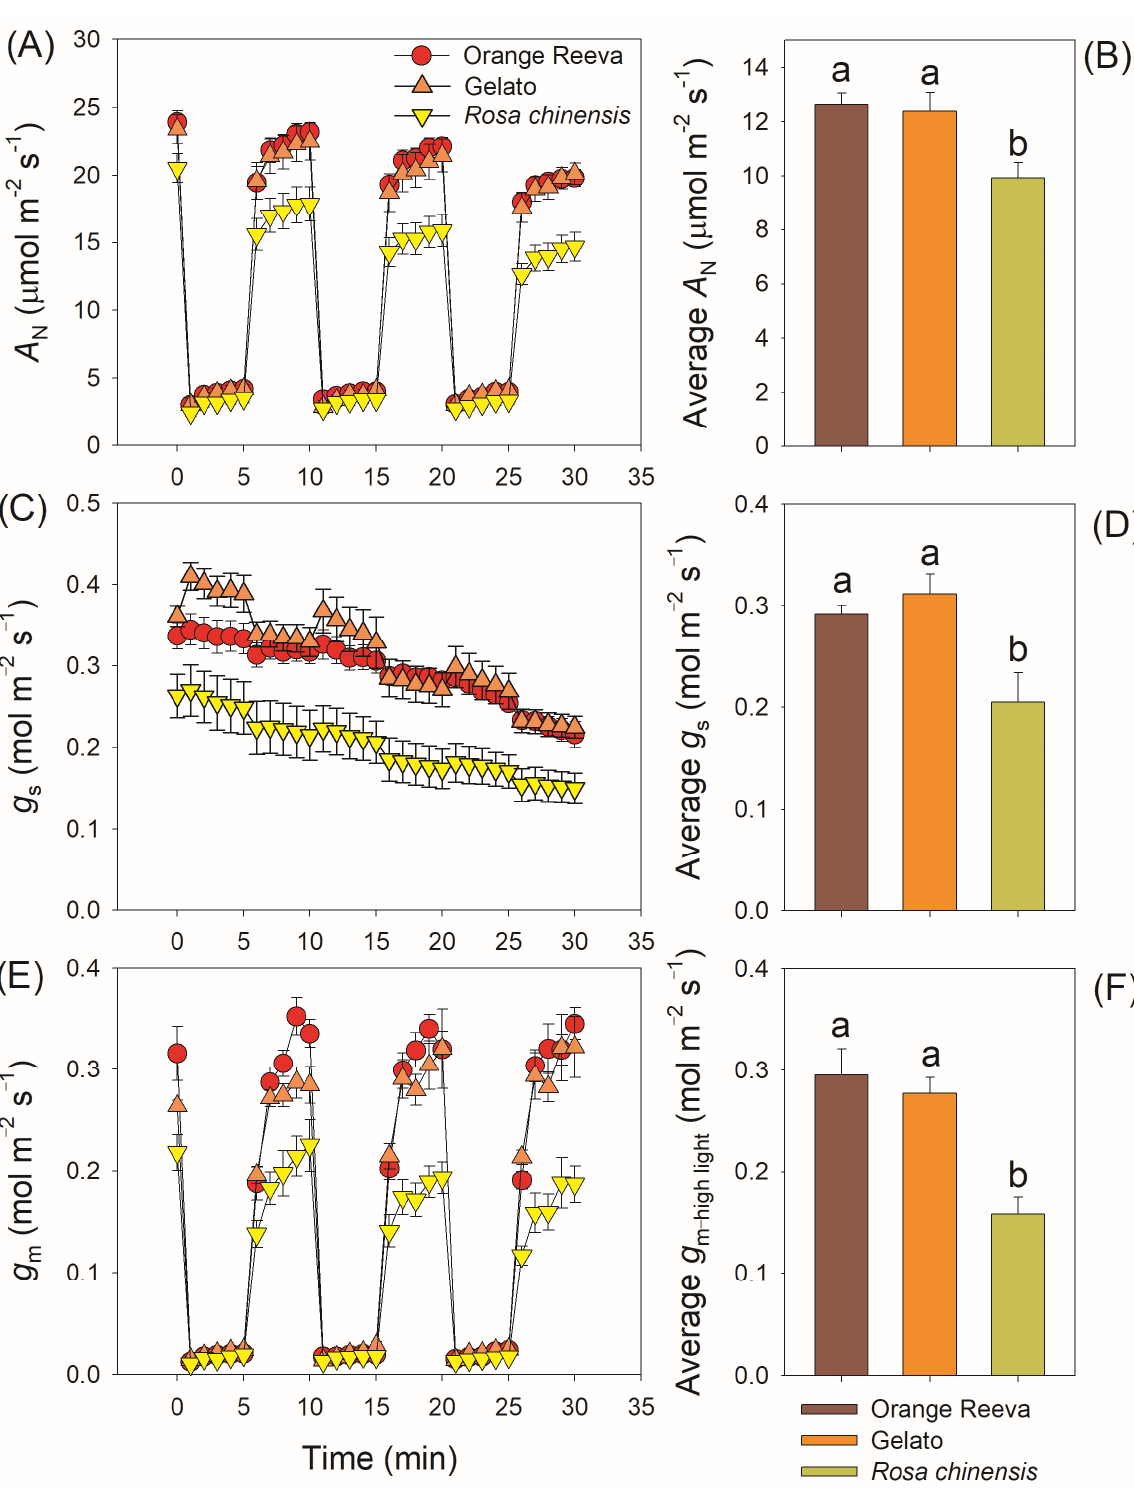
Figure 3. Dynamic changes and average values of leaf net CO 2 assimilation rate ( A N ) ( A , B ), stomatal conductance ( g s ) ( C , D ), and mesophyll conductance ( g m ) ( E , F ) under fluctuating light in two modern rose cultivars (Orange Reeva and Gelato) and the old Chinese rose plant Rosa chinensis . Adapted leaves were exposed to four repeated cycles of 100 and 1500 µ mol photons m − 2 s − 1 (every 5 min). Data are means ± SE ( n = 5).